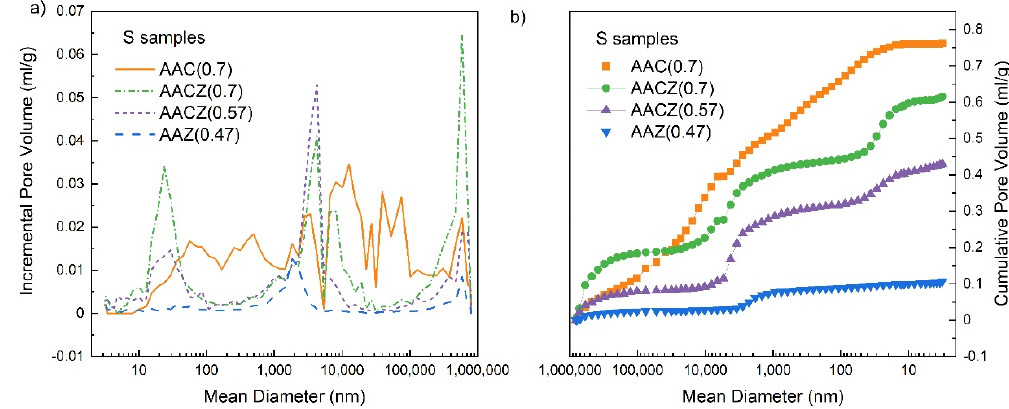
Figure 4. Pore size distribution ( a ) and intrusion curves ( b ) of S samples, determined using Hg porosimetry.